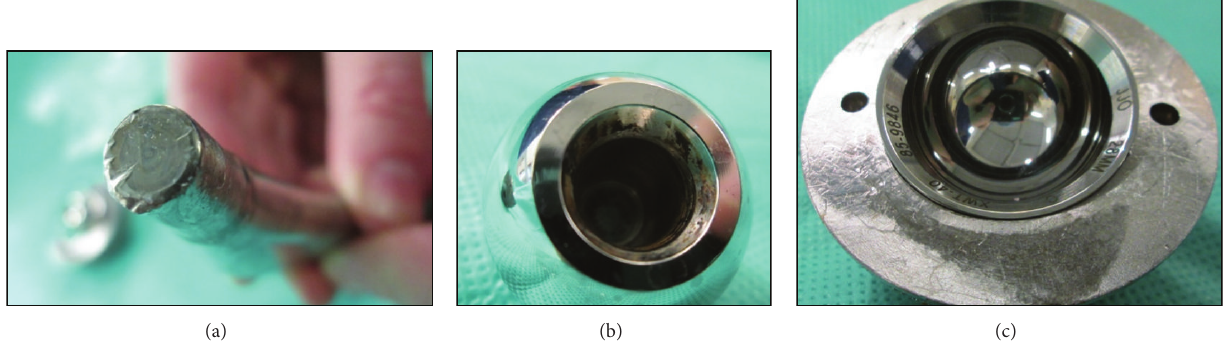
Figure 3: (a) Visible wear and damage on the trunnion (the significant deformation at the tip was caused by surgical removal of the well-fixed stem), (b) black debris in the articulating surface of the femoral head, and (c) minimal wear or damage to the metal liner.